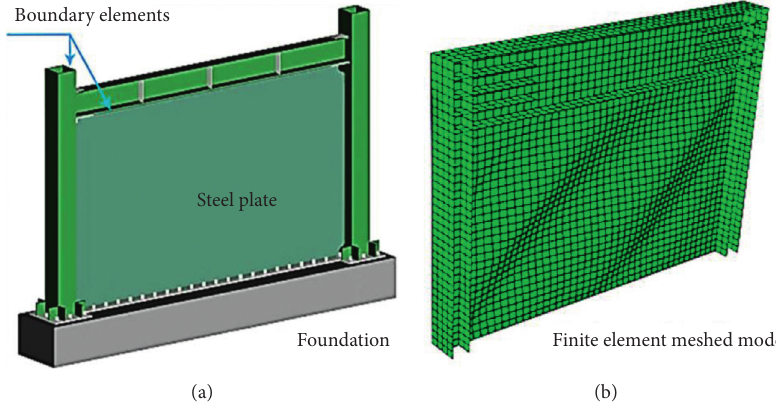
Figure 4: Longitudinal and cross section of the